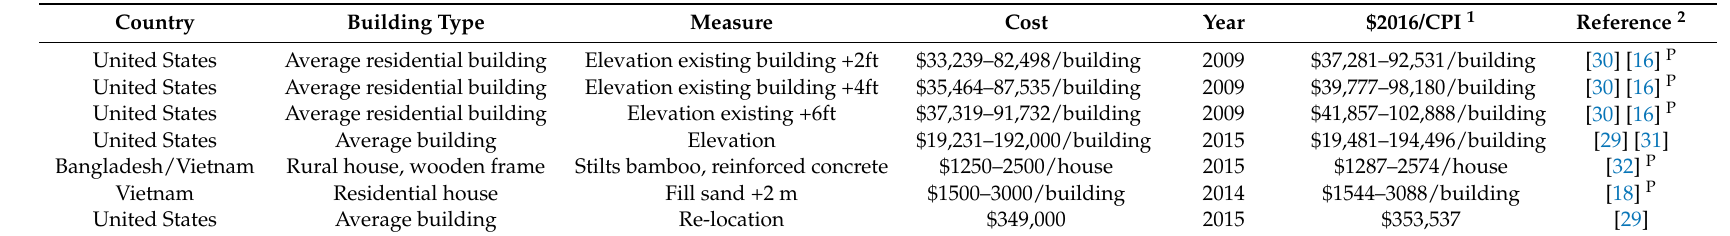
Table 1. Cost for elevation (U.S.$) and re-location of